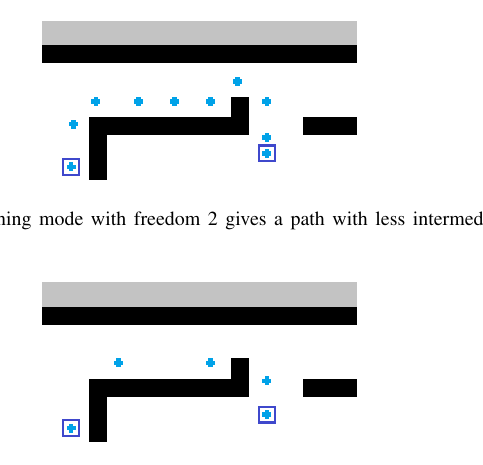
Fig. 6. Planning mode with freedom 5 gives a path without sufficient points, which may lead the agents to a wall which they behavior is not enough to avoid.